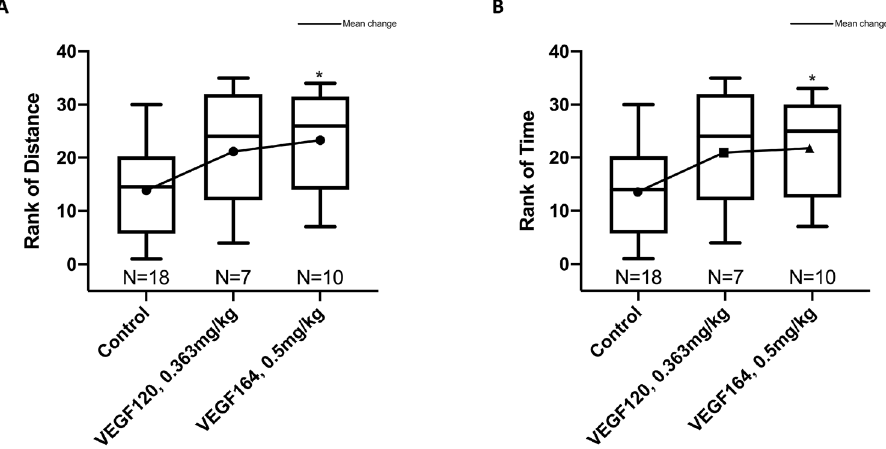
Figure 3. Treadmill exercise tolerance testing. Rank-based analysis of covariance, adjusted for baseline outcome and multiple pairwise comparisons, showed greater mean change in VEGF164 vs. control ( P = 0.03 for distance and for time), with no differences between VEGF120 and control ( P = 0.11 for distance and P = 0.09 for time) and no differences between VEGF120 and VEGF164 ( P = 0.64 and P = 0.66 for distance and time, respectively) ( A , B ). Statistical analysis of exercise tolerance was performed by nonparametric ANCOVA of the change in distance or time (POD4 minus baseline) and adjusted for multiple pairwise corrections using the Holm-Sidak correction. Results are expressed as median and interquartile range (IQR), with mean values. *P < 0.05. Mouse cohorts of pneumonectomies were performed in three independent repeats. On any given operative day, a control group of mice was